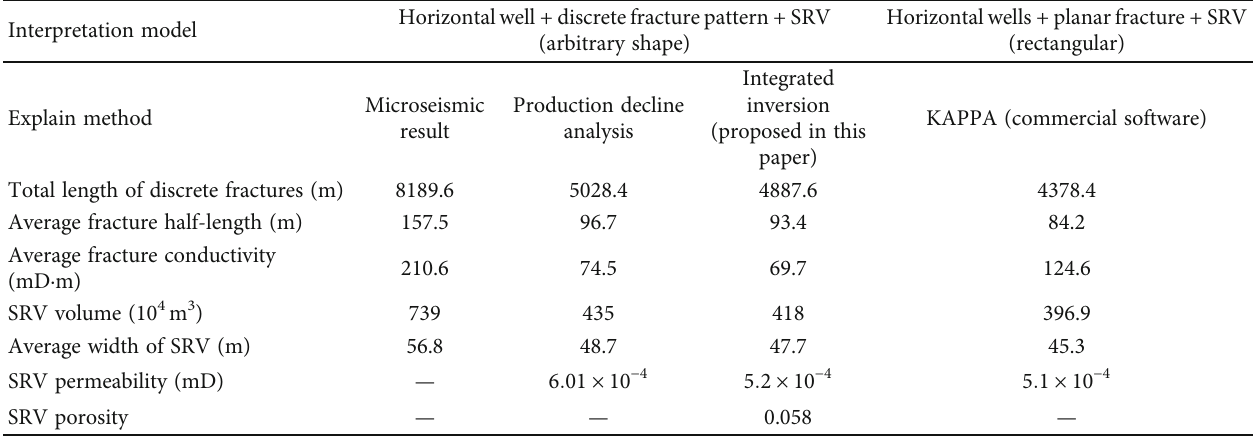
Table 3: Comparison of interpretation